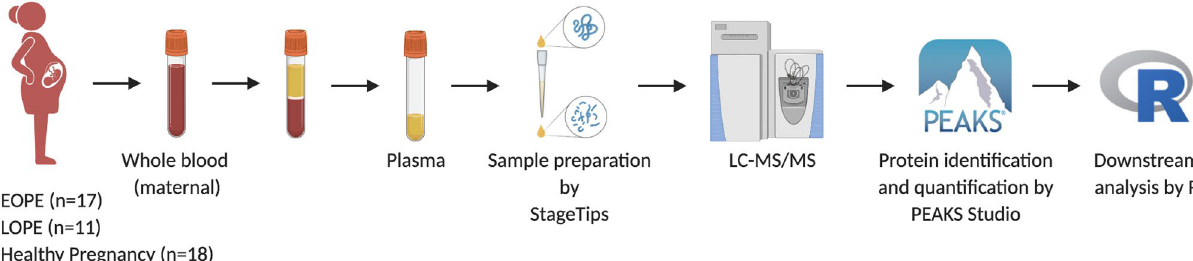
Figure 5. Overview of the experimental design and data